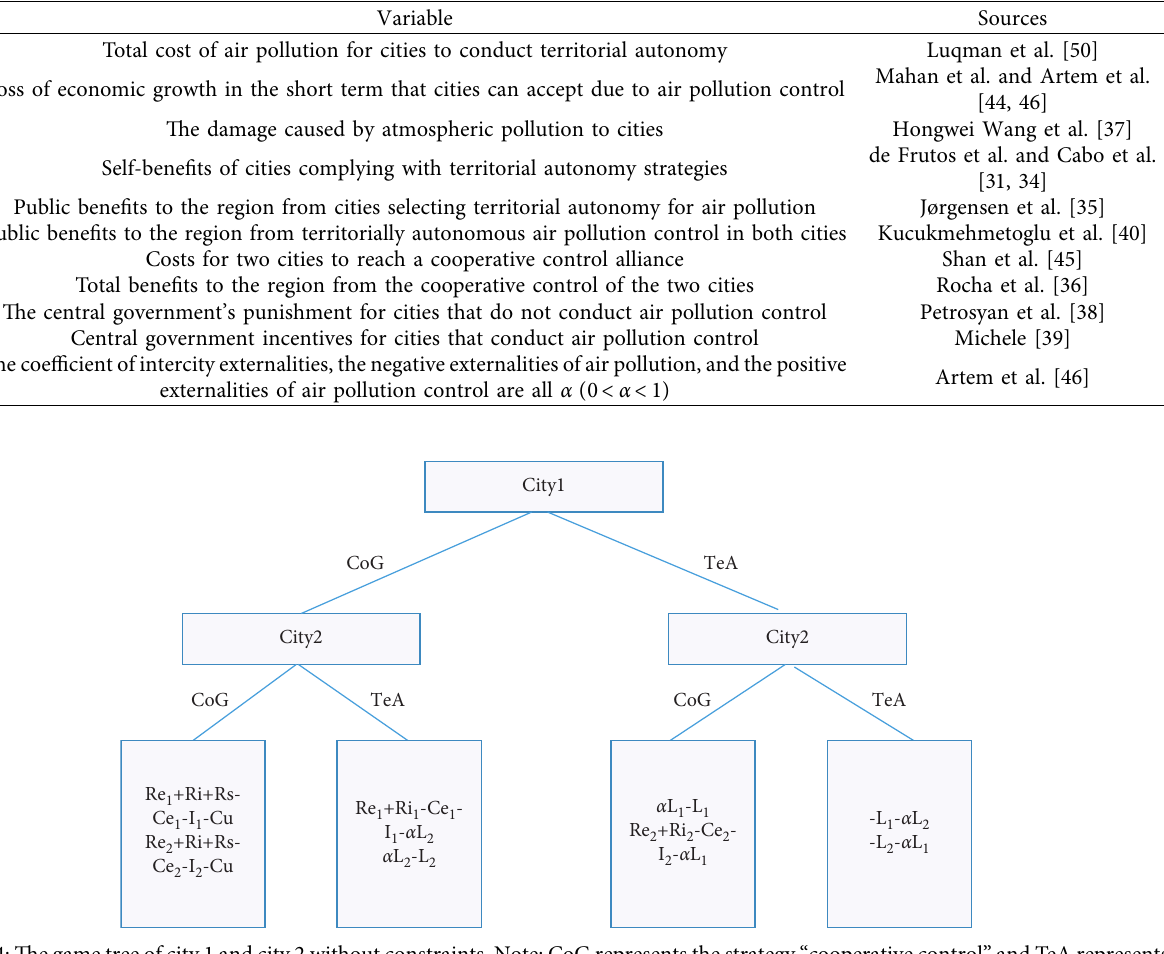
Table 3: Main parameters and their meaning.